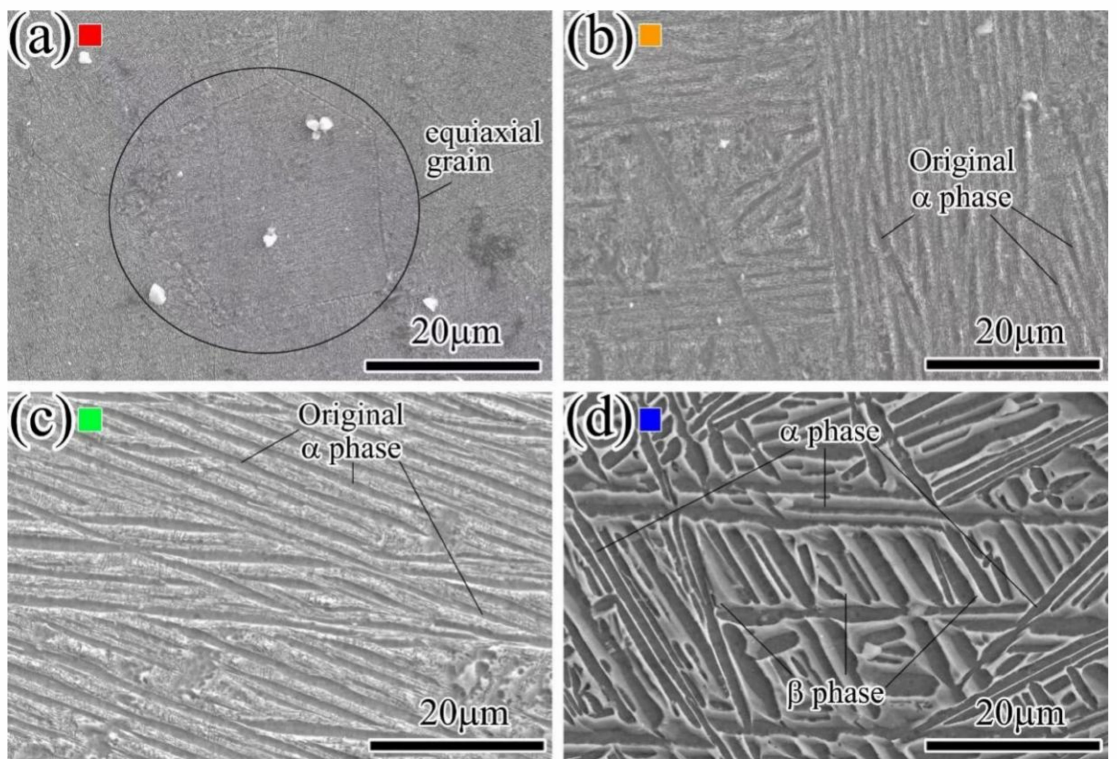
Figure 3. SEM microstructure photos of different zones of the IFW joint ( a ) WZ; ( b ) TAMZ; ( c ) HZ ( d )